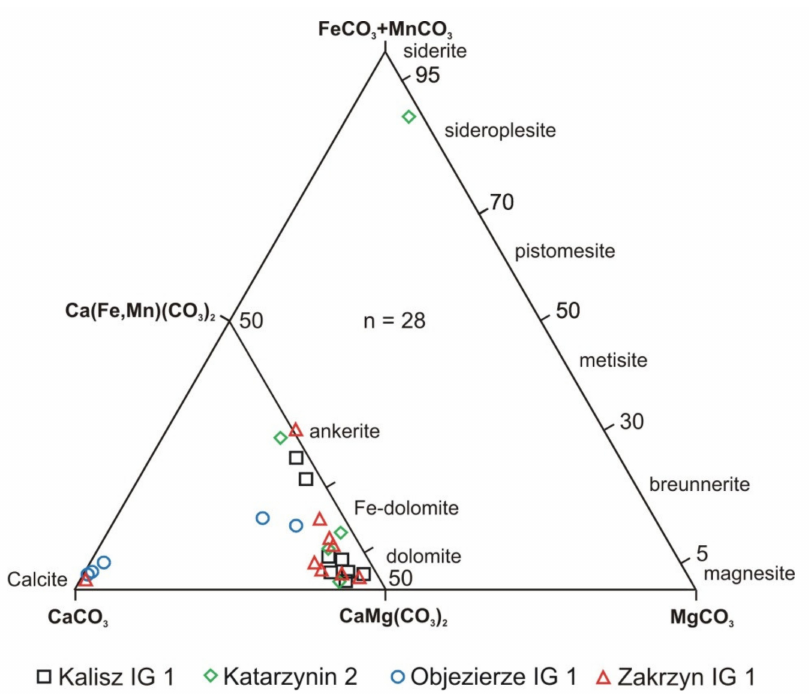
Figure 4. Ternary plot of the carbonates’ chemical compositions at mole %; n—analysis number.